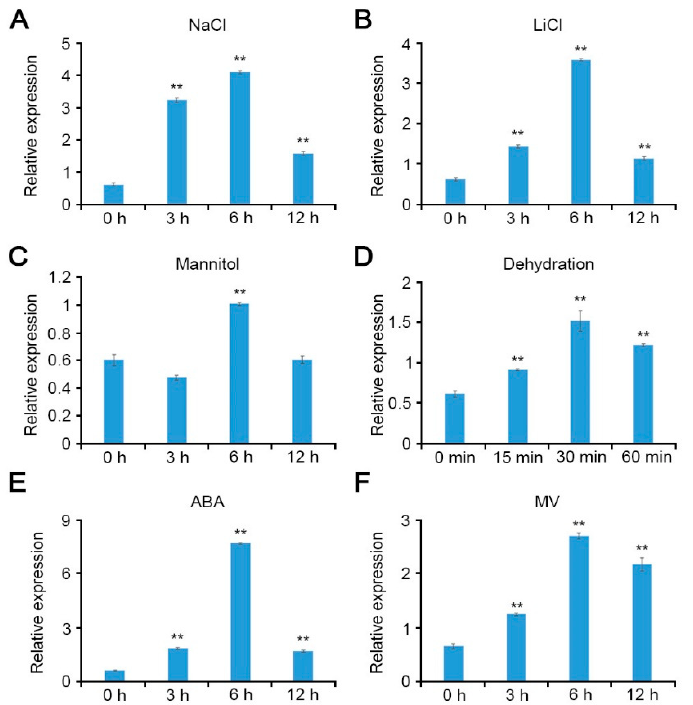
Figure 1. Transcriptional responses of CCoAOMT1 toward various abiotic stresses. Relative transcript levels of CCoAOMT1 were analyzed via quantitative real time-PCR (qRT-PCR). Total RNAs were extracted from 10-day-old Arabidopsis seedlings grown on 1/2 MS medium treated with ( A ) 100 mM NaCl, ( B ) 10 mM LiCl, ( C ) 100 mM mannitol, ( D ) dehydration, ( E ) 100 µ M abscisic acid (ABA), or ( F ) 10 µ M methyl viologen (MV) at the indicated time points. Expression of TUBULIN2 was used for normalization. Bars represent mean ± SD of three biologic replicates with three technical replicates each. Asterisks represent significant differences from the control (0 h; ** p < 0.01, Student’s t -test).